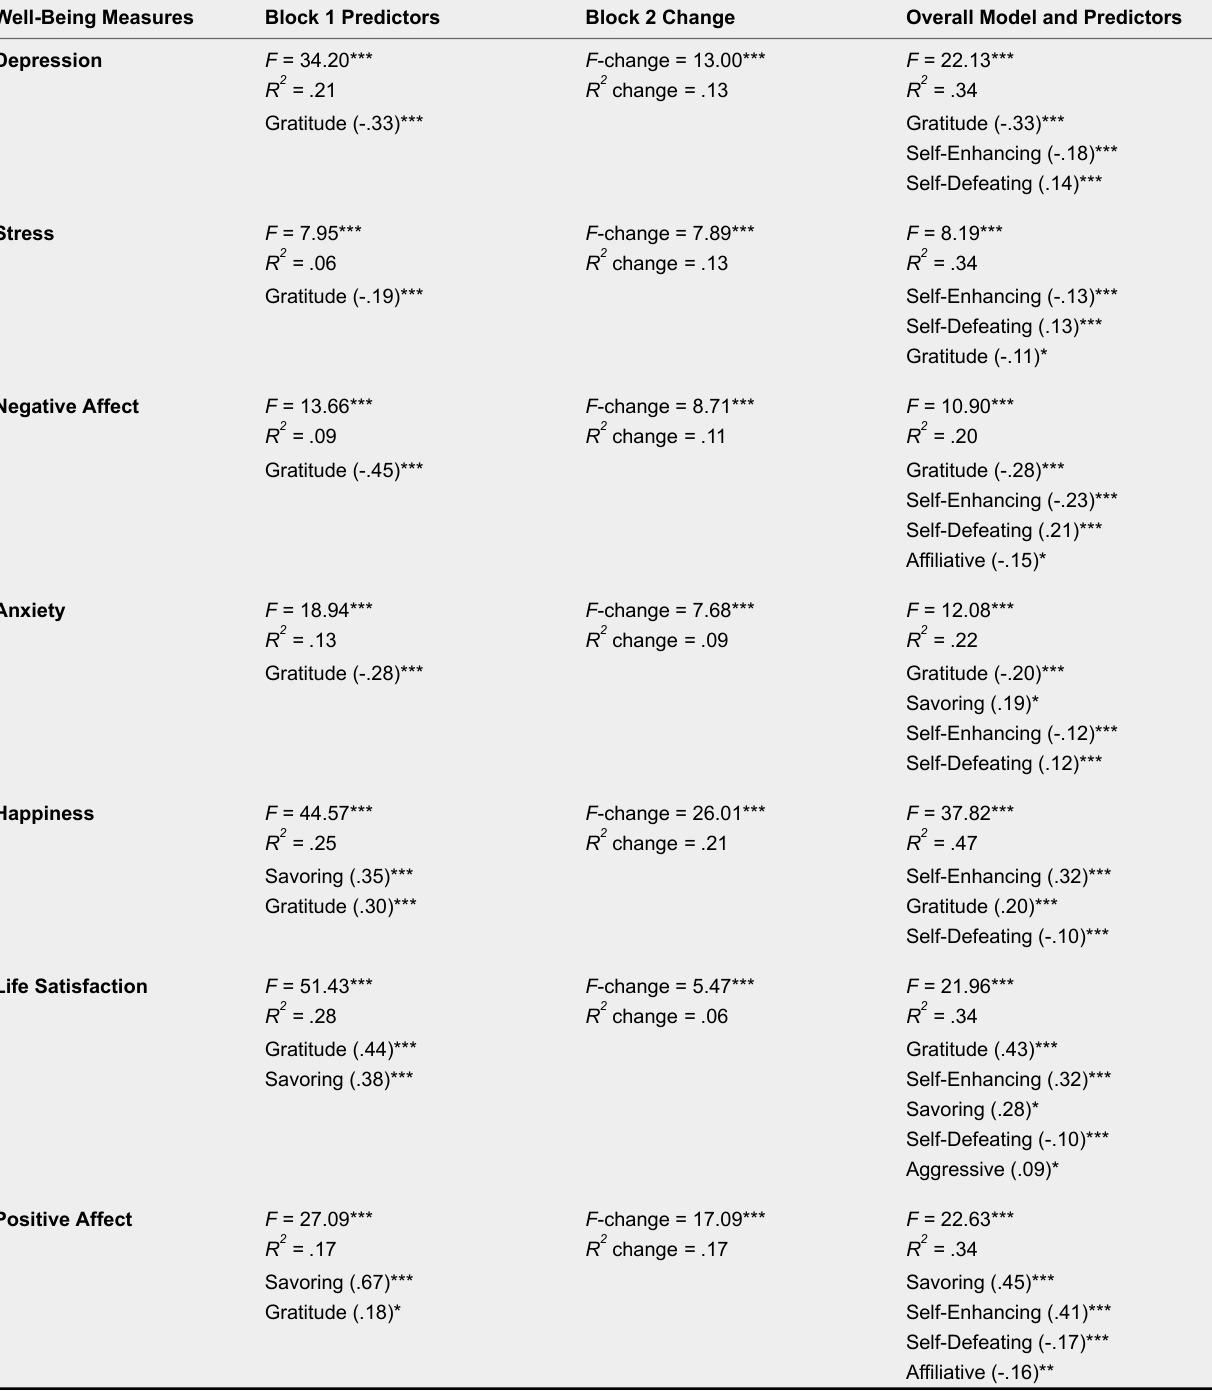
Summary of Significant Findings and Regression Coefficients for All Regression Analyses